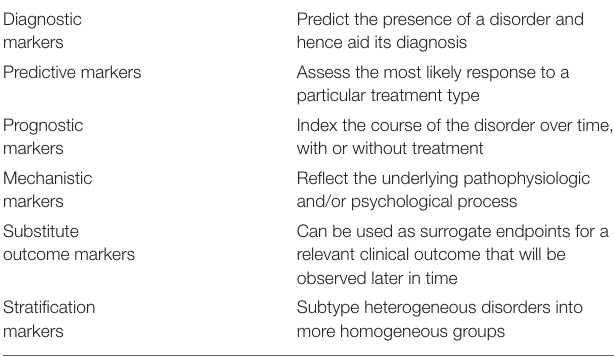
TABLE 1 | Different types of